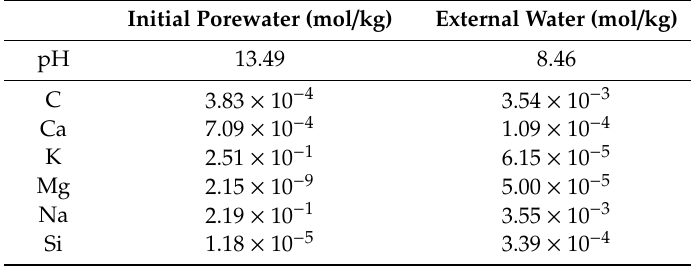
Table 2. Water compositions. The external water is based on a calcite-equilibrated calculation with FRHP water [31] and the initial porewater is equilibrated with the cement material for Backfill (Table 1). Initial Porewater (mol /